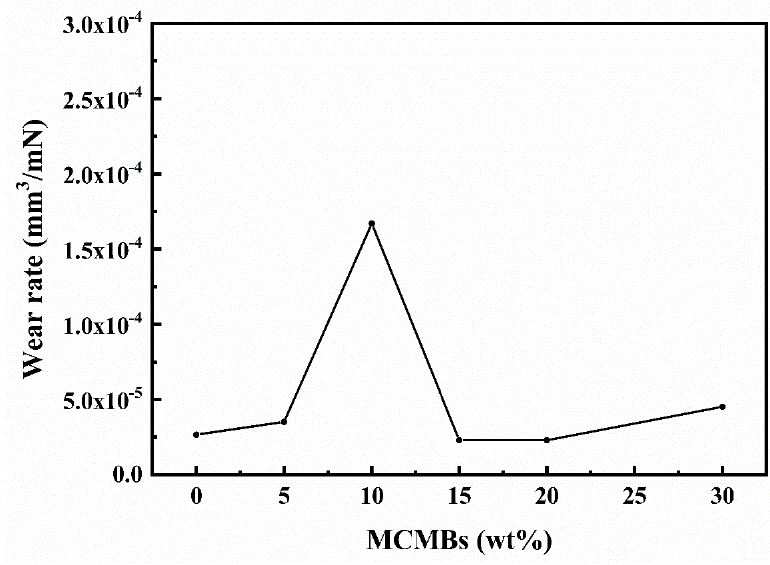
Figure 9. Relationship between MCMB content of the samples and wear rate.